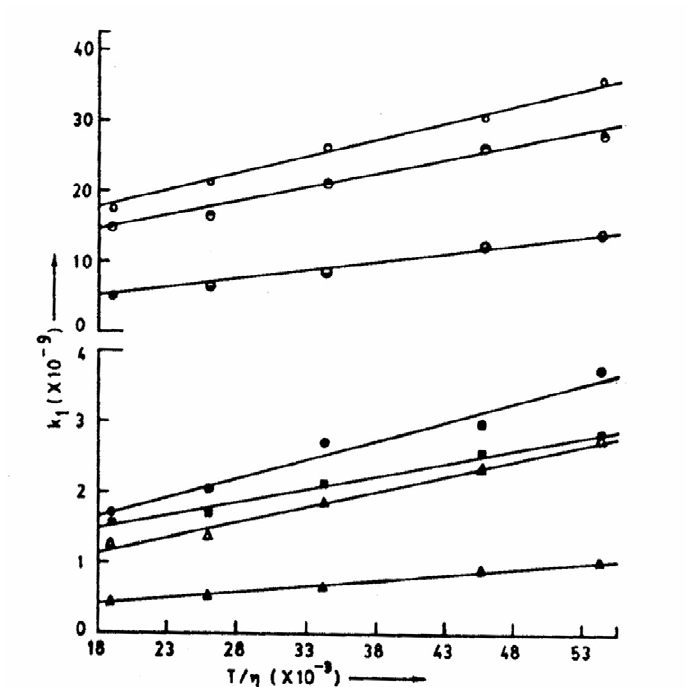
NH, CAZL-EtNH , CAZL-Et N and 2 2 3